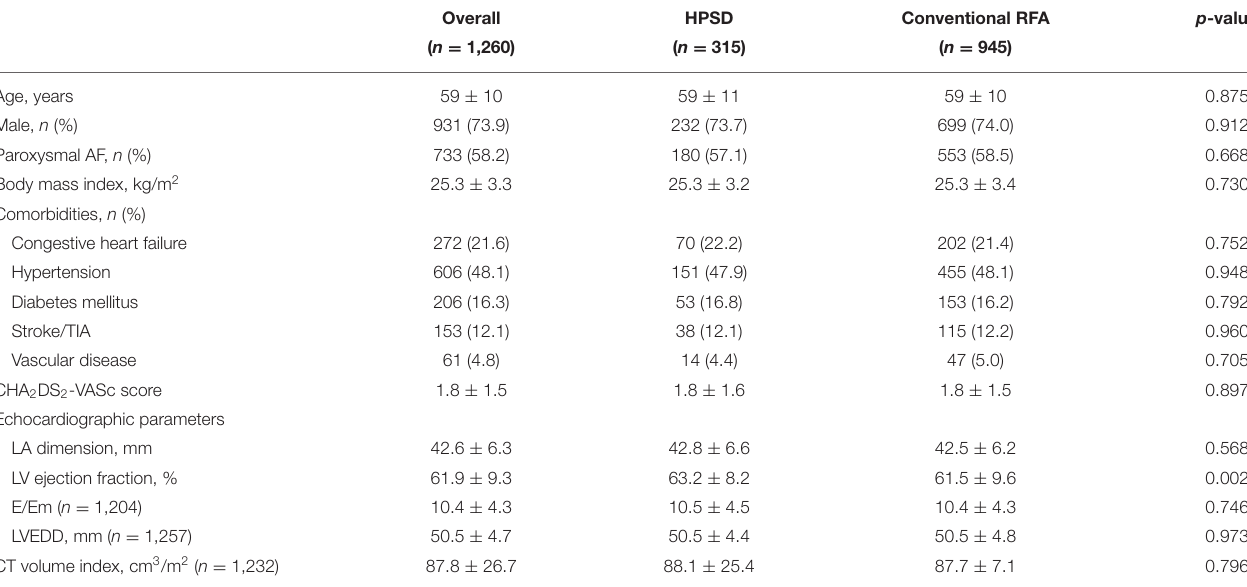
TABLE 1 | Baseline characteristics in propensity-score matched